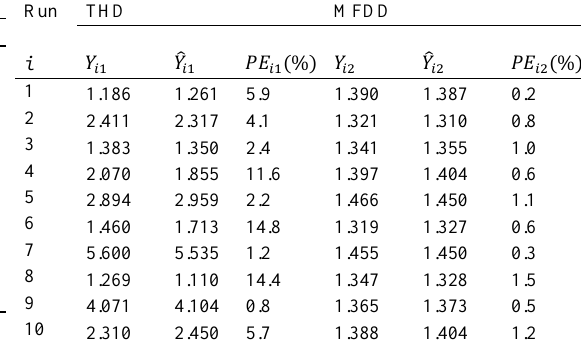
Table 5. The prediction performance of the models.